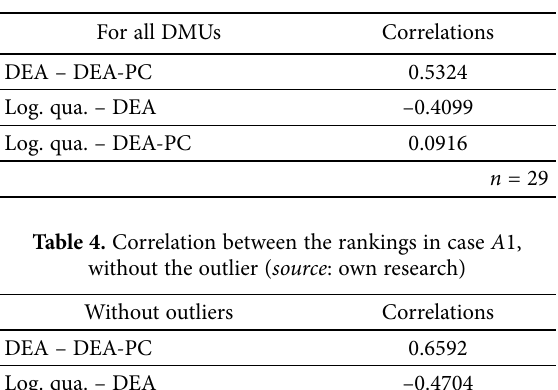
Table 3. Correlation between the rankings in case A 1, considering all the countries in the sample